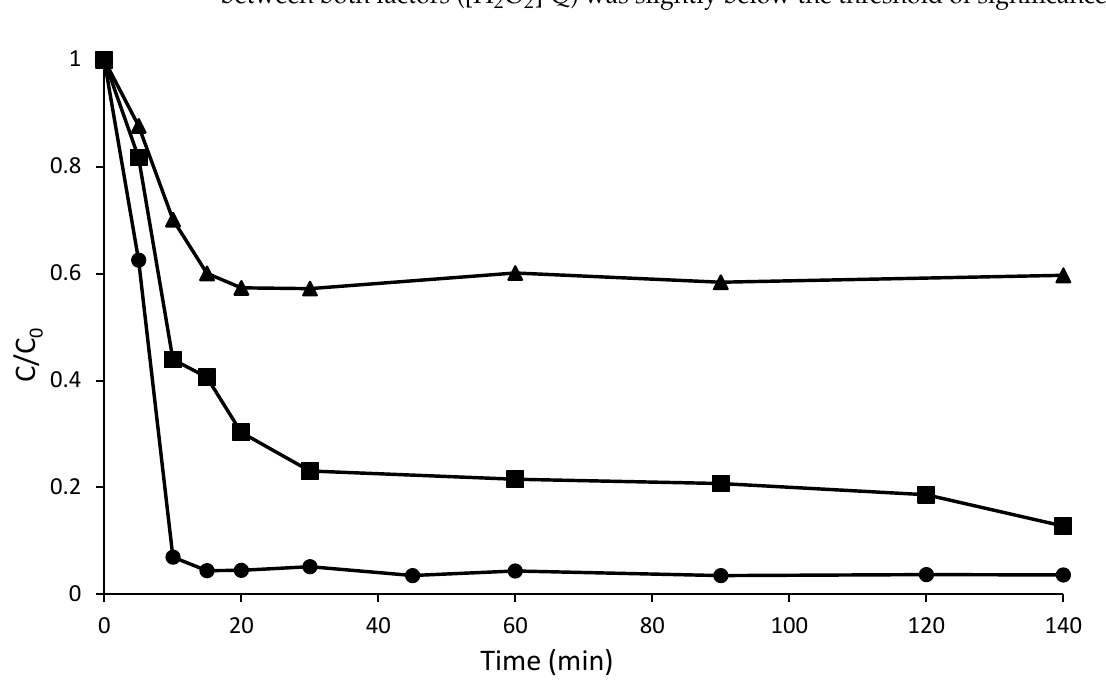
Figure 4. Plot of the relative concentration of acetaminophen at the outlet of the reactor when operated in the continuous mode under different conditions: UVC ( ▲ ), UVC + H 2 O 2 (21 mM) ( ■ ) and UVC + H 2 O 2 (21 mM) + bubbling air ( ● ).